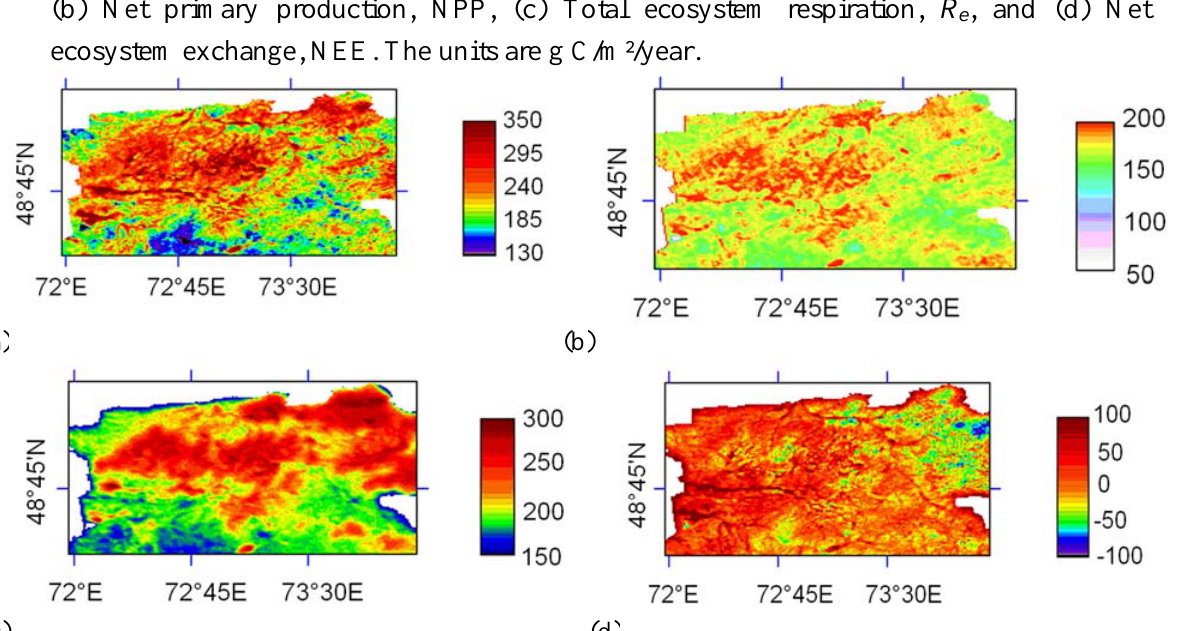
Figure 3. Spatial distribution of the modelling results, (a) Gross primary production, GPP, (b) Net primary production, NPP, (c) Total ecosystem respiration, R ecosystem exchange, NEE. The units are g